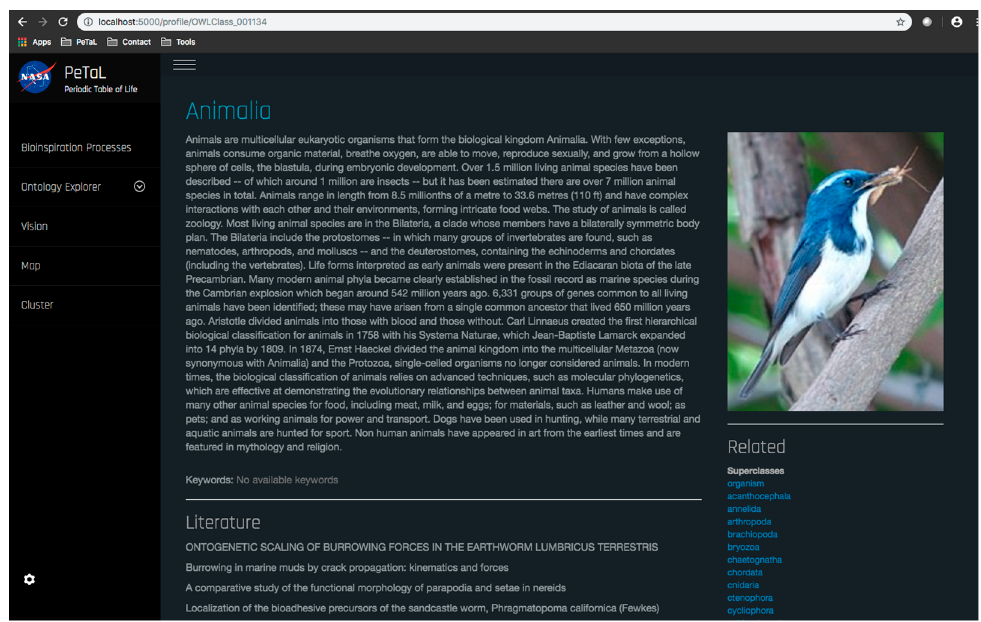
Figure 26. PeTaL node profile page showing information regarding specific node/entity from ontology and database. Designs 2019 , 3 , x FOR PEER REVIEW